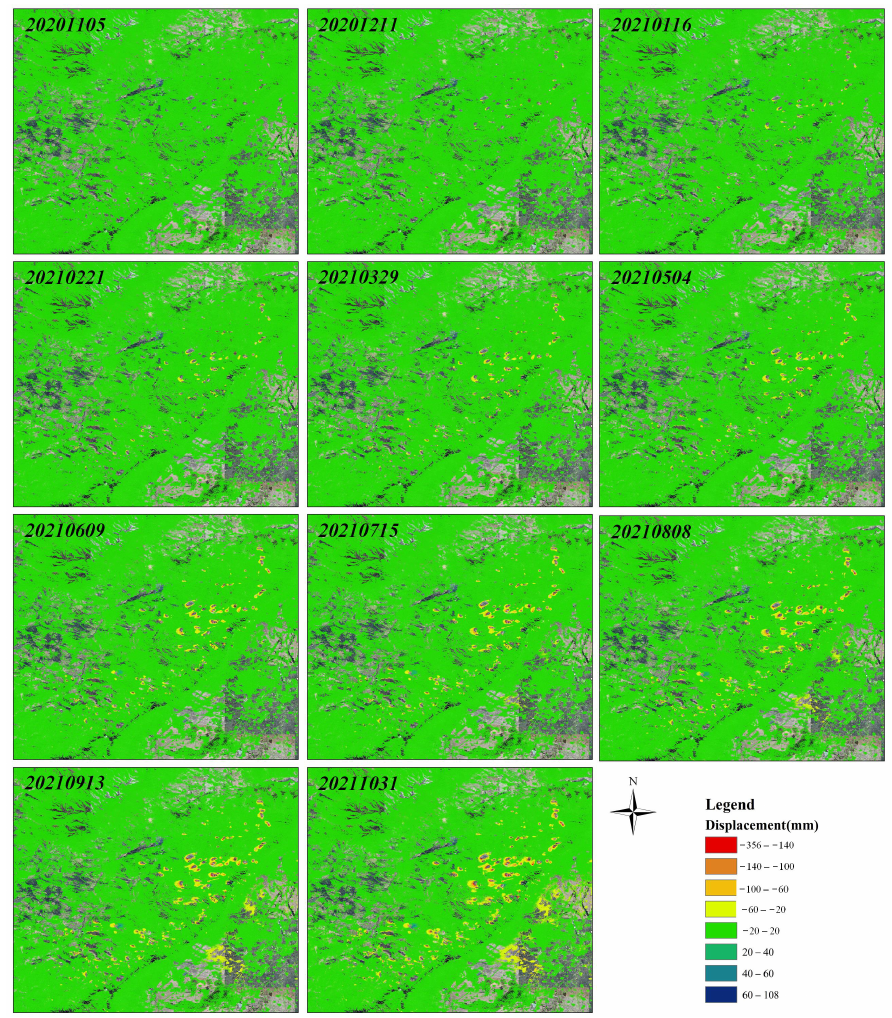
Figure 8. Cumulative time-series deformation of the Datong coalfield.